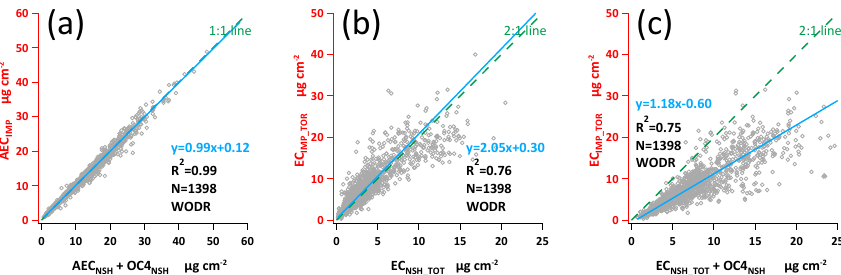
Figure 3. Comparison of different carbon fractions. (a) Relationship of IMPROVE apparent EC (AEC IMP , sum of EC1 IMP to EC3 IMP ) and the sum of NIOSH apparent EC (AEC NSH , sum of EC1 NSH to EC6 NSH ) plus OC4 NSH , (b) relationship of EC IMP_TOR ( y axis) and EC NSH_TOT ( x axis), and (c) relationship of EC IMP_TOR ( y axis) and the sum of EC NSH_TOT and OC4 NSH ( x axis). WODR stands for weighed orthogonal distance